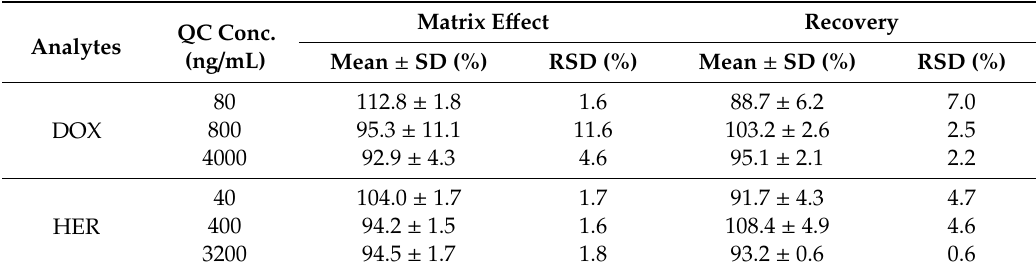
Table 3. Matrix e ff ect and recovery of doxorubicin and hernandezine in plasma of rats (n = 5). Analytes